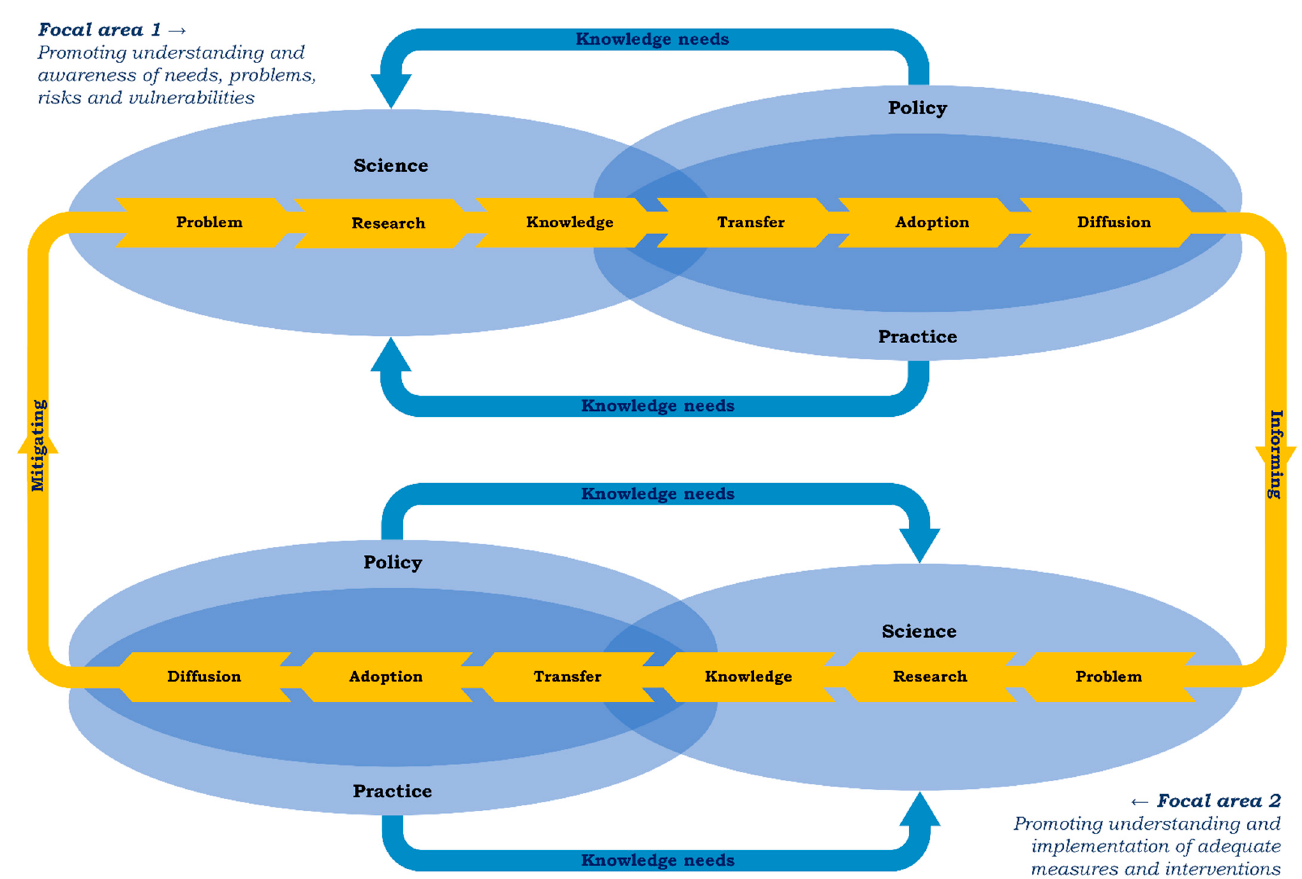
Figure 1. Disaster risk reduction through knowledge development and application. Shown here are two focal areas with series of steps that ideally influence each other. Knowledge about needs, problems, risks, and vulnerabilities, generated and shared in Focal area 1 can inform the activities in Focal area 2 to mitigate issues of concern. The exchange between stakeholders from science, policy, and practice is important to produce knowledge and tools (co-learning) based on scientific methods (verified, tested) and relevant for policy and practice (support, ownership).